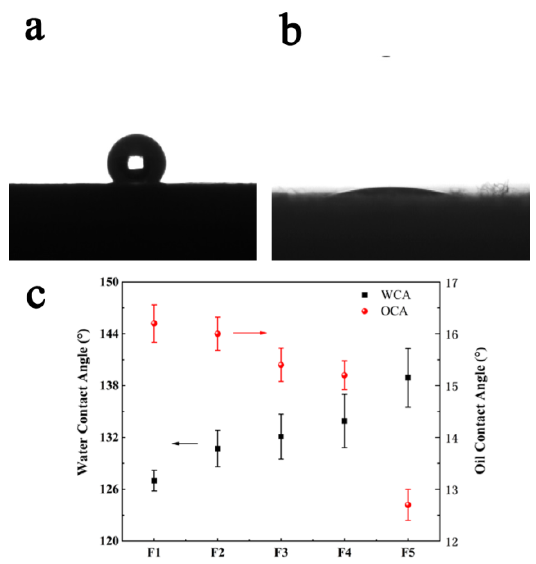
Figure 5. The wettability of fibers is presented: ( a ) the WCA of fibers prepared by the 21 G needle, ( b ) the OCA of fibers prepared by 21 G the needle, ( c ) the WCAs and OCAs of the fiber membranes for samples obtained using different needle diameters.